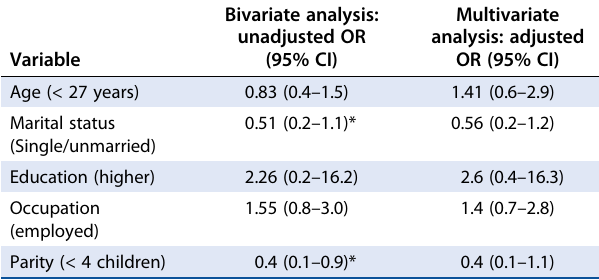
Table 3: Bivariate and multivariate analysis of sociodemographic factors of patients associated with Implanon uptake of patients attending a